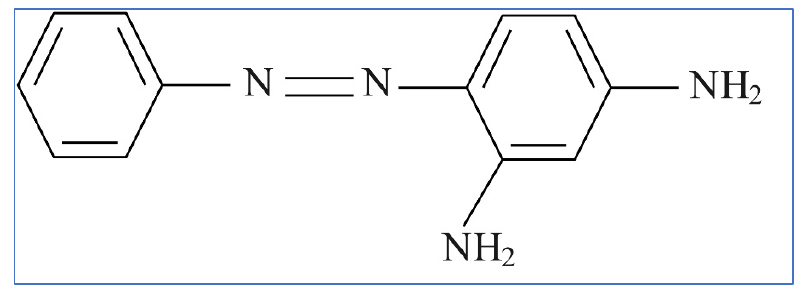
Figure 10. Typical structure of chrysoidine azo dye.